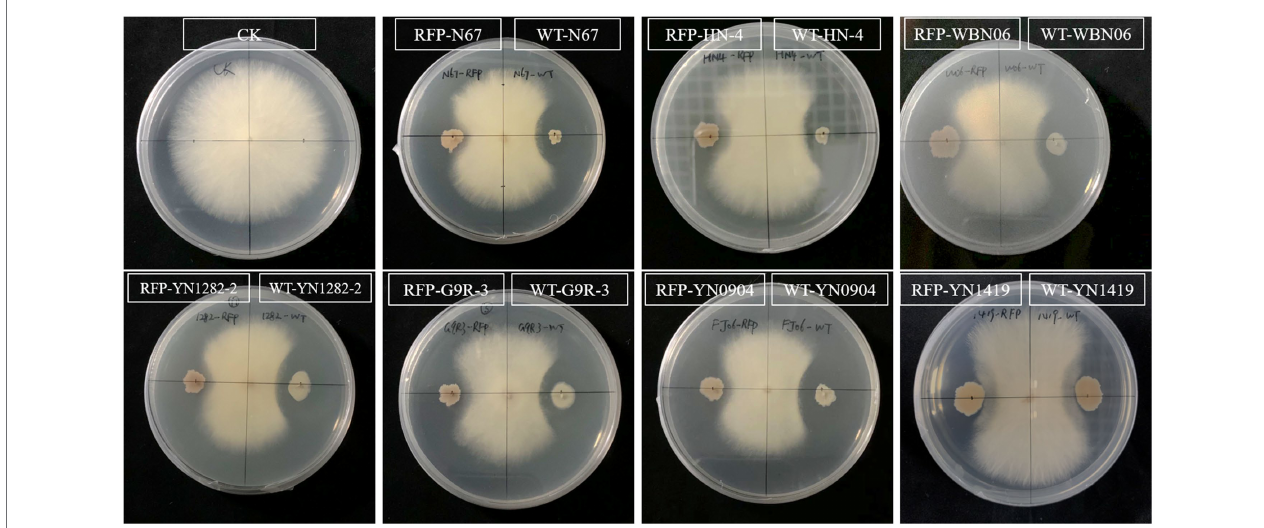
FIGURE 5 | Antagonistic effect of RFP-labeled Bacillus compared to the WT Bacillus . The plate inoculated with pathogen only was used as the control (CK). The antagonistic effect of RFP-strains (left) and WT strains (right), respectively, and the pathogen was inoculated in the center. Five replicates were